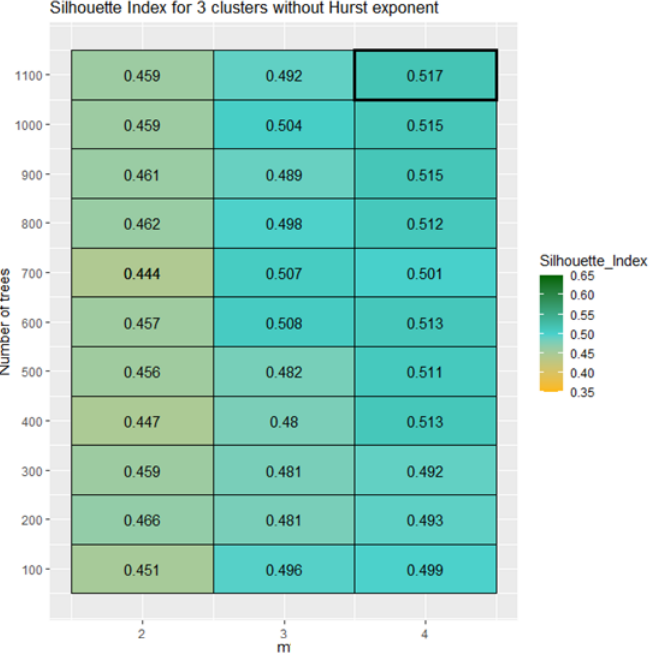
Figure A3. Silhouette indexes for three clusters for URF not using any Hurst exponent. “m” represents the number of predictors tested on each node.